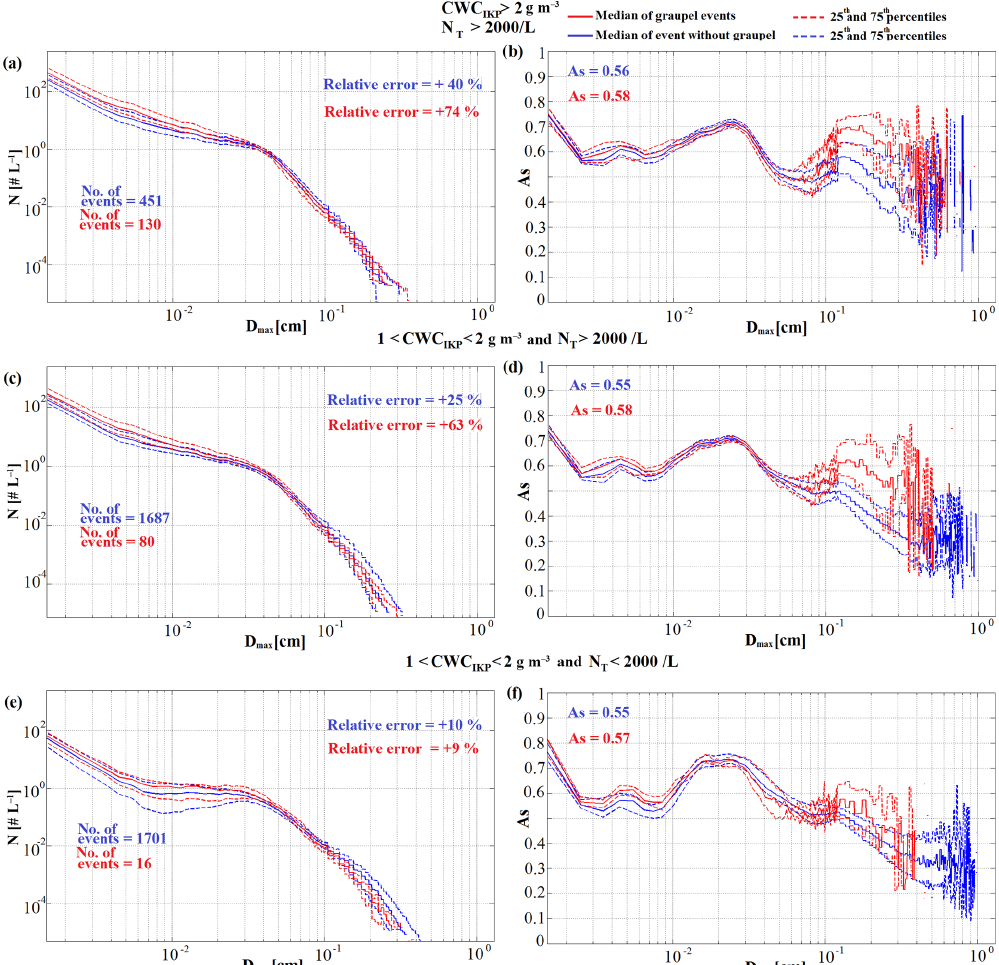
Figure 9. For three cloud categories discussed in Sect. 5, (a, c, e) show the number size distributions of ice crystals and (b, d, f) present the respective aspect ratio distributions of ice hydrometeors as a function of crystal size on the x axis. Median distributions are indicated by a solid line and the 25th and 75th percentiles by dashed lines. The red curves are used for events where graupel are detected, whereas blue is used for events without graupel particles. In addition, median relative errors of retrieved uncorrected CWCs, corresponding median aspect ratios, and number of observed events (for both graupel and non-graupel events) are added as numbers in the